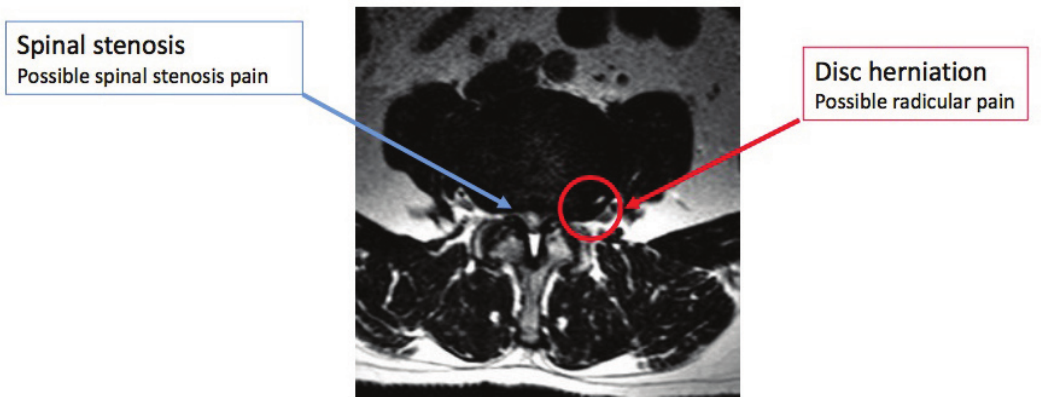
Figure 2. MRI axial image showing reduction in the size of the spinal canal (blue arrow), a pathogenetic finding in spinal stenosis; the red arrow shows radicular compression that can cause radicular